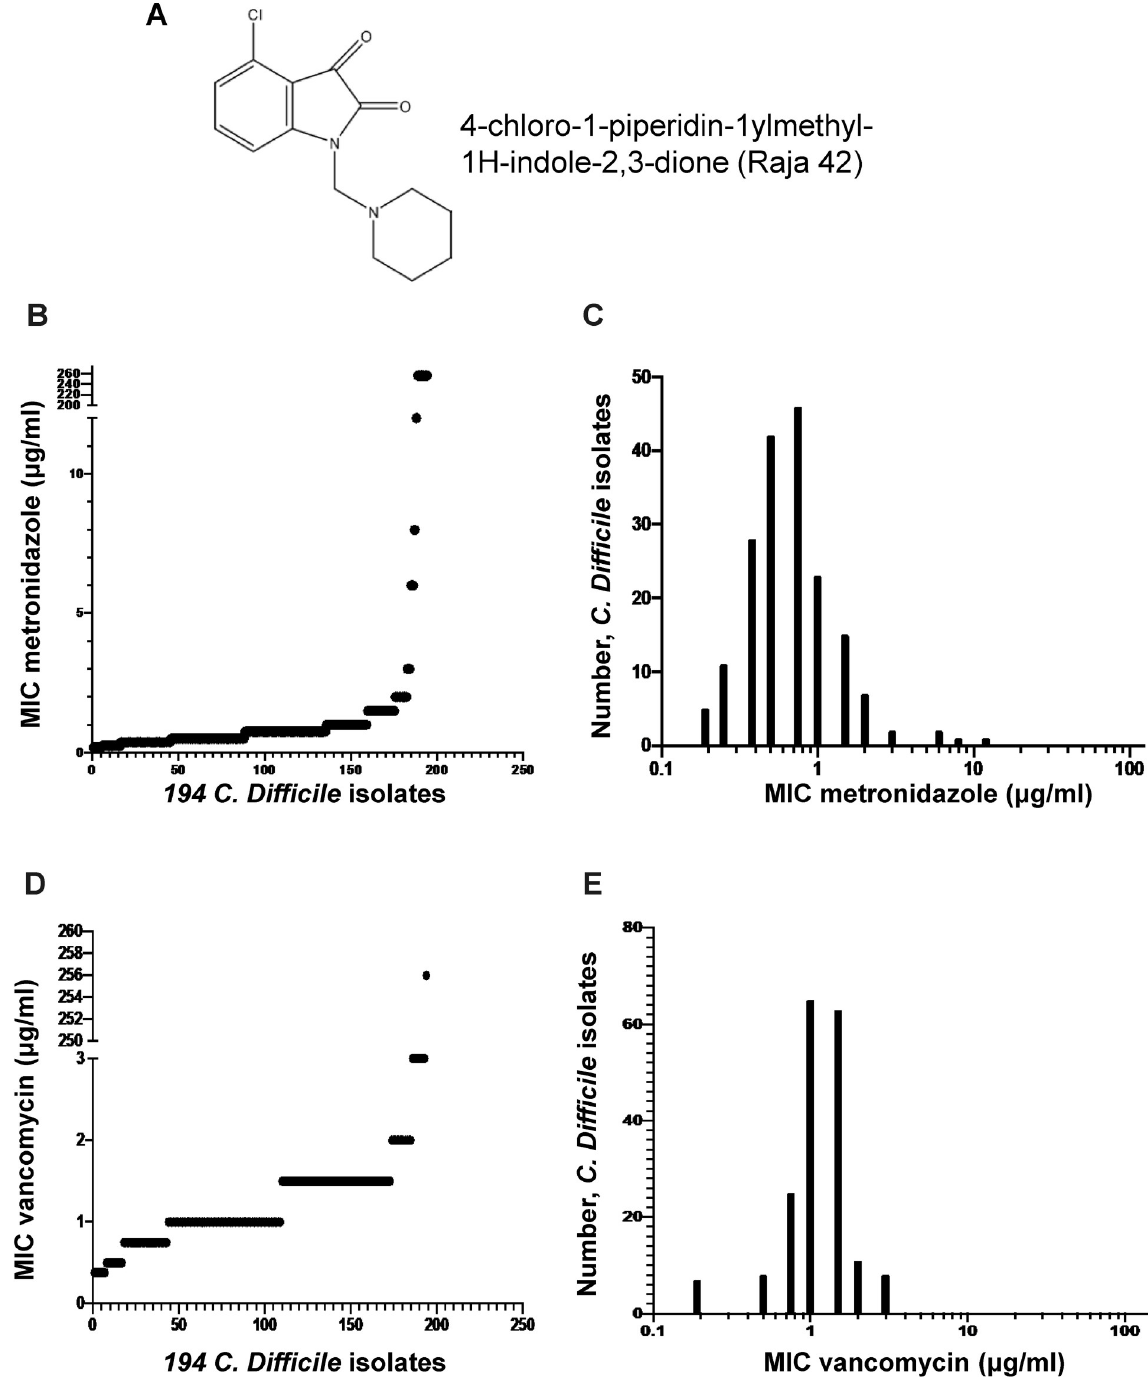
Fig 1. Distribution of metronidazole and vancomycin MIC against C . difficile clinical isolates. (A) The chemical structure and name of Raja 42 are shown. (B-E) Metronidazole and vancomycin were determined for their MIC values on 194 C . difficile clinical isolates (S1 Table). The susceptibility of these isolates to metronidazole or vancomycin was determined according to the guideline recommended by EUCAST and CLSI. The MIC value of metronidazole against C . difficile is 2 μ g/mL, according to which 12 of the isolates were resistant to metronidazole (B, C). Vancomycin MIC against C . difficile is 2 μ g/mL (D, E).